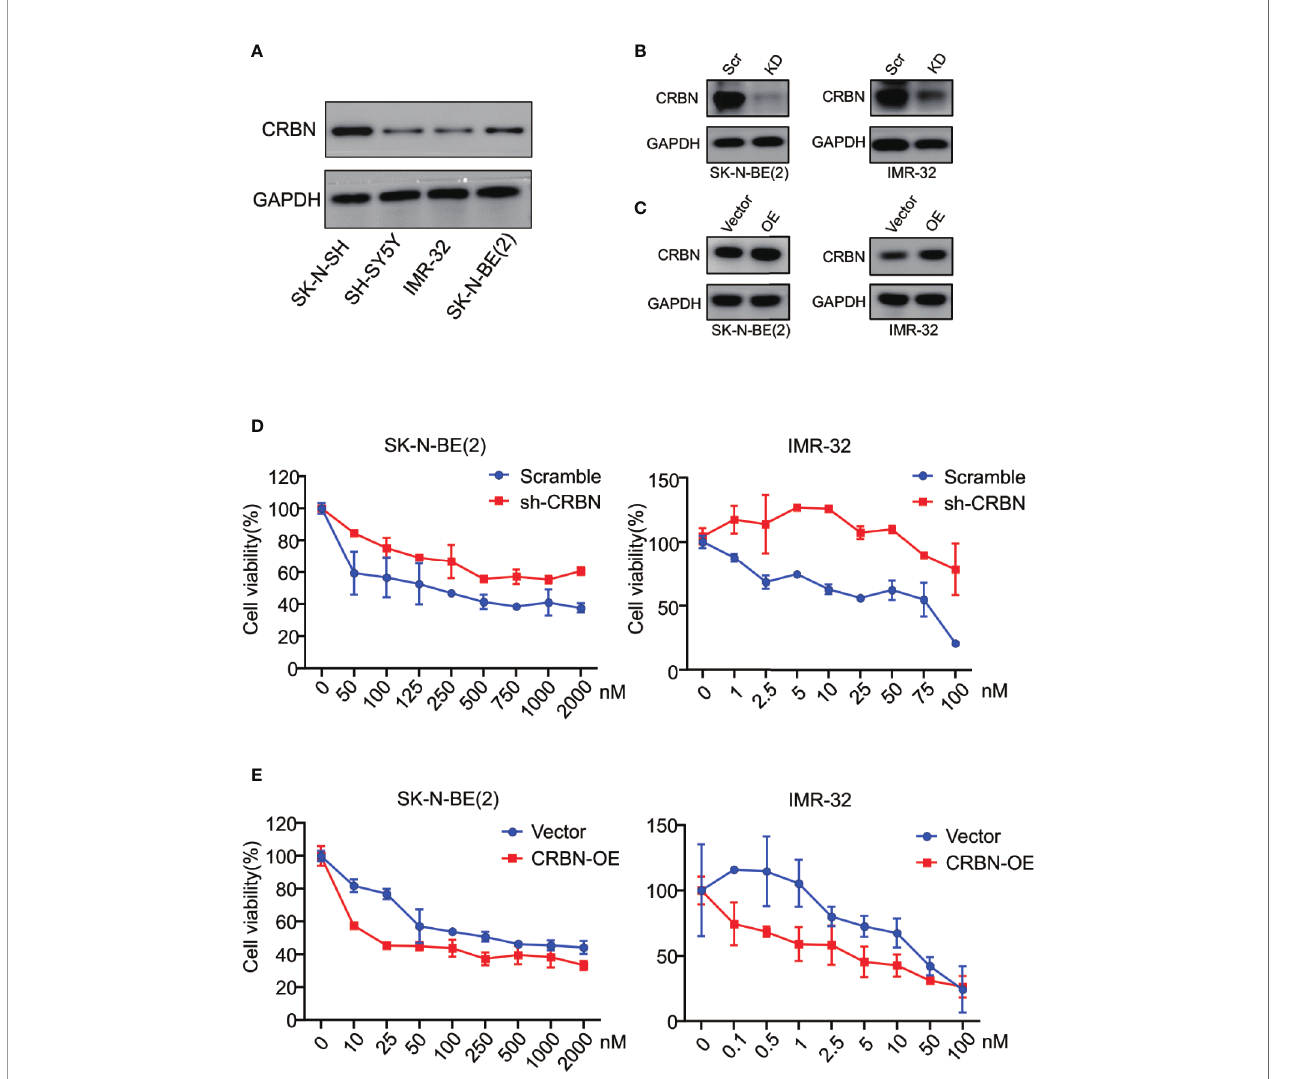
FIGURE 4 | CRBN is indispensable in responsiveness to ARV-825 in NB cells. (A) Western blot analysis showed basal CRBN protein level in NB cells. (B) Knockdown of CRBN expression by sh-CRBN lentivirus in SK-N-BE(2) (left) and IMR-32 (right) cells. Scr, Scramble; KD, knockdown. (C) Overexpressing CRBN in SK-N-BE(2) (left) and IMR-32 (right) cells. OE, overexpression. (D) Comparison of sensitivity to ARV-825 of cells transfected by sh-CRBN with cells transfected by sh-scramble in SK-N-BE(2) (left) and IMR-32 (right) cells. (E) Comparison of sensitivity to ARV-825 of cells overexpressing CRBN with cells transfected by empty vector alone in SK-N-BE(2) (left) and IMR-32 (right) cells. OE,